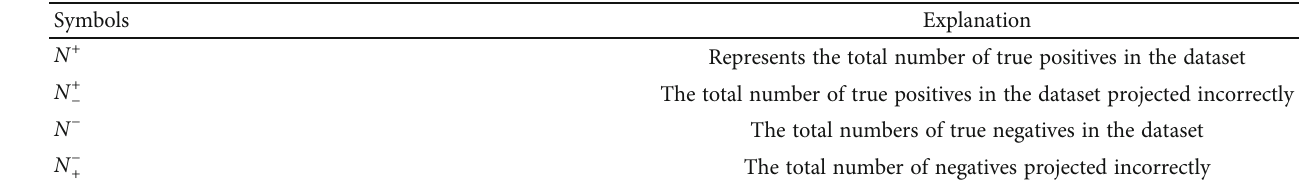
Table 1: New symbol description for Chou ’ s fourth step.